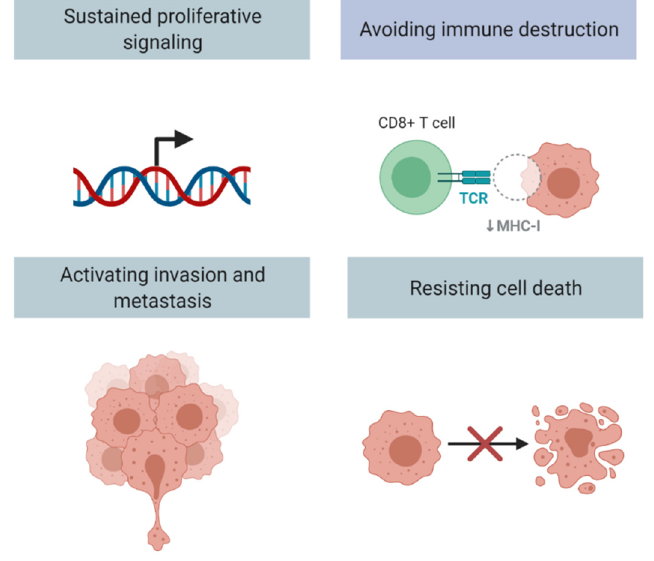
Figure 1. TGF- β pathway and related hallmarks of cancer (adapted from “Hallmarks of Cancer”, by BioRender.com (2021). Retrieved from https://app.biorender.com/biorender-templates, accessed on 14 October 2021).